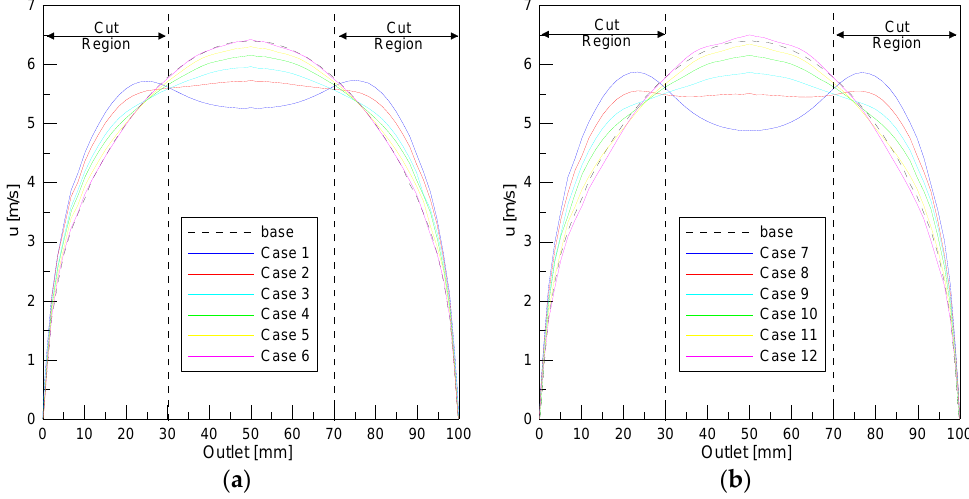
Figure 10. Velocity profiles for non-Newtonian fluid ( n = 0.7669).